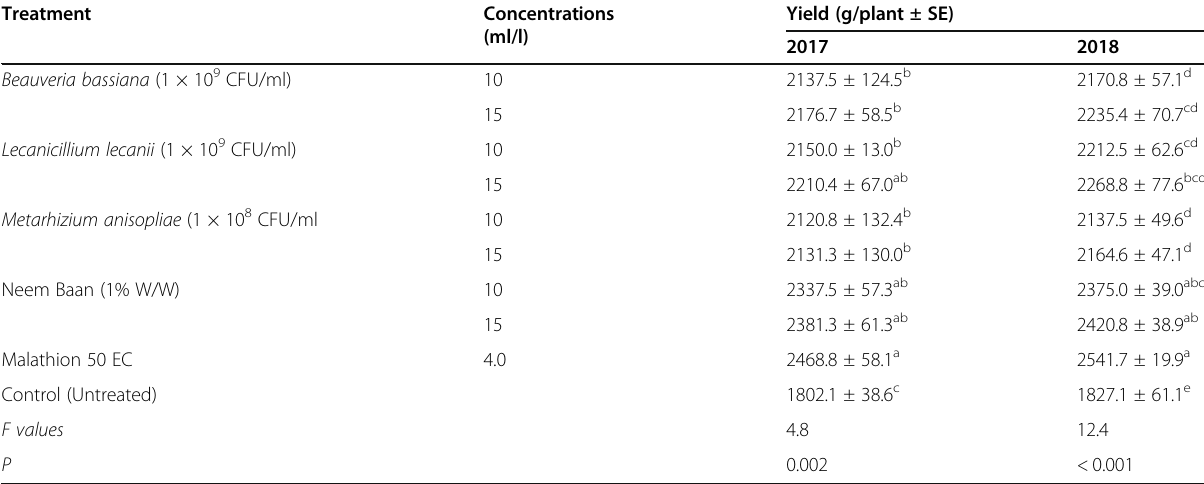
Table 8 Marketable yield of parthenocarpic cucumber in different biopesticidal treatments against Bemisia tabaci during autumn cropping seasons